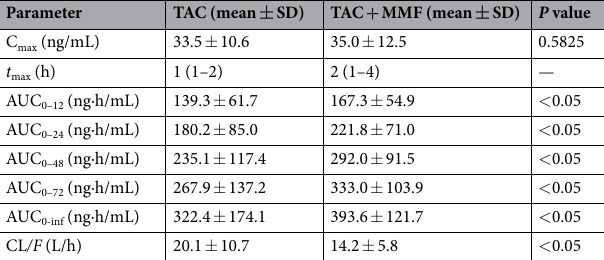
Table 2. Pharmacokinetic parameters of tacrolimus estimated by the non-compartmental analysis after administration of TAC alone or in combination with MMF. TAC, tacrolimus; MMF, mycophenolate mofetil; SD, standard deviation; C max , maximum concentration; t max , time of maximum concentration; AUC, area under the blood concentration-time curve from time 0 to infinity or pre-specified time points; CL/F , apparent clearance. CL /F was calculated from dose and AUC 0-inf ; t max is presented as median (min-max); P value was obtained by paired t -test or signed rank